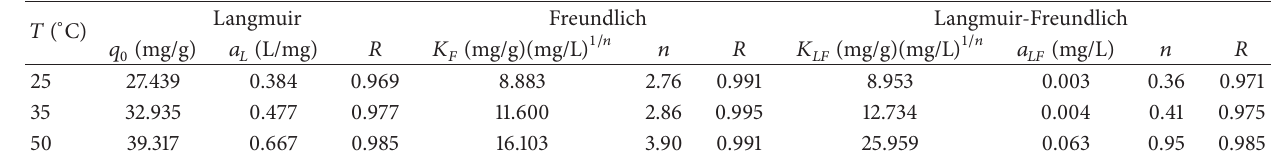
Table 3: Isotherm model parameters and correlation coefficients ( R ) for cadmium biosorption by CAB.